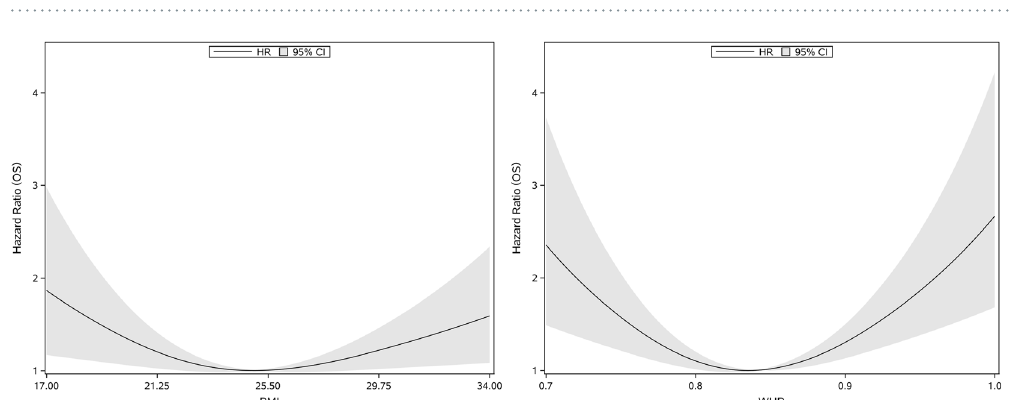
Figure 1. Association of post-diagnosis ( A ) BMI and ( B ) WHR with late all-cause mortality. The graphs were truncated at the 1st and 99th percentiles with curve representing HRs and band representing 95%